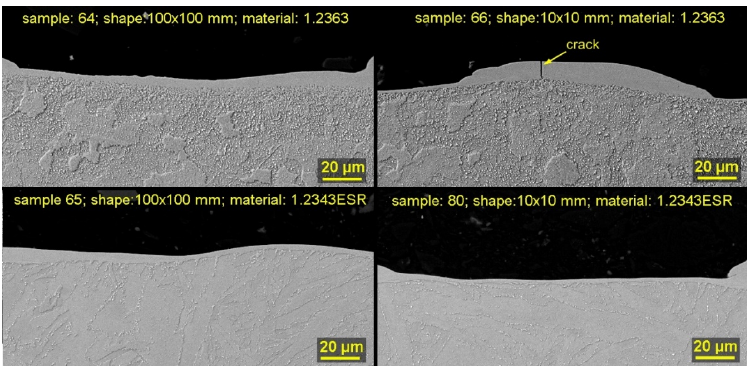
Figure 6. Showing the state of the subsurface sample layer and defects, SEM (BSE).